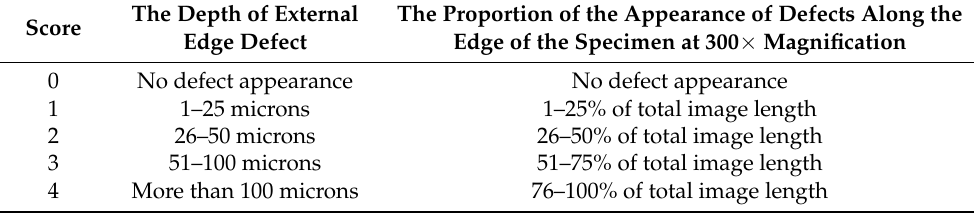
Table 1. Scoring of the depth of the external edge effect and the proportion of the appearance of the defect along the edge used for a defect score calculation in external edge defect